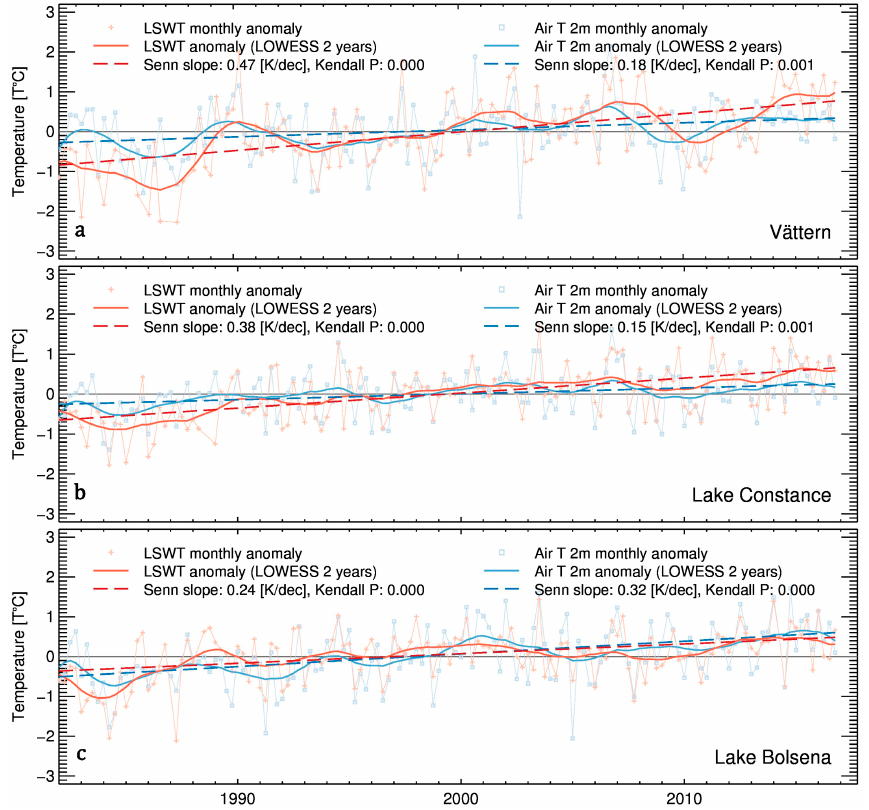
Figure 13. Comparison of LSWT trends with local air temperature trends (extracted from ERA INTERIM) at Lake Vättern ( a ), Lake Constance ( b ), and Lake Bolsena ( c ).